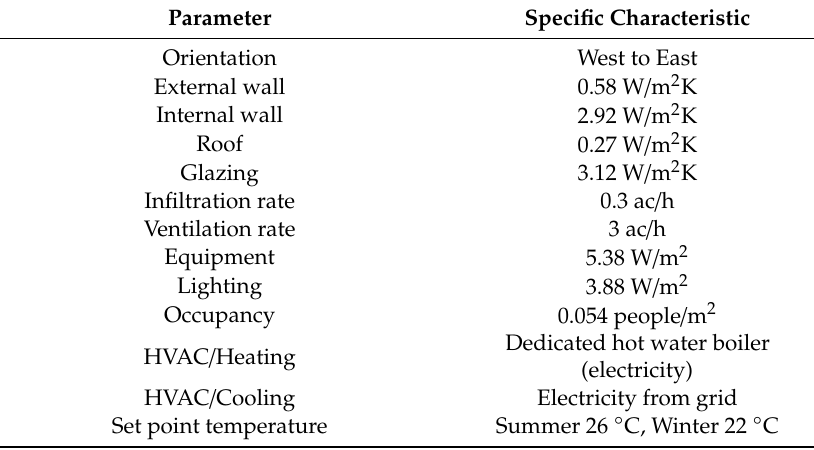
Table 3. Construction